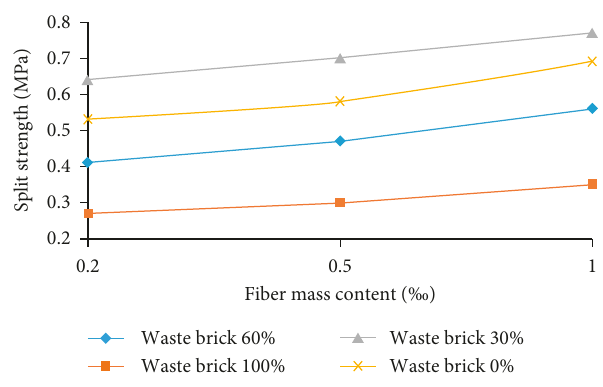
Figure 18: Influence of fiber content on splitting strength.